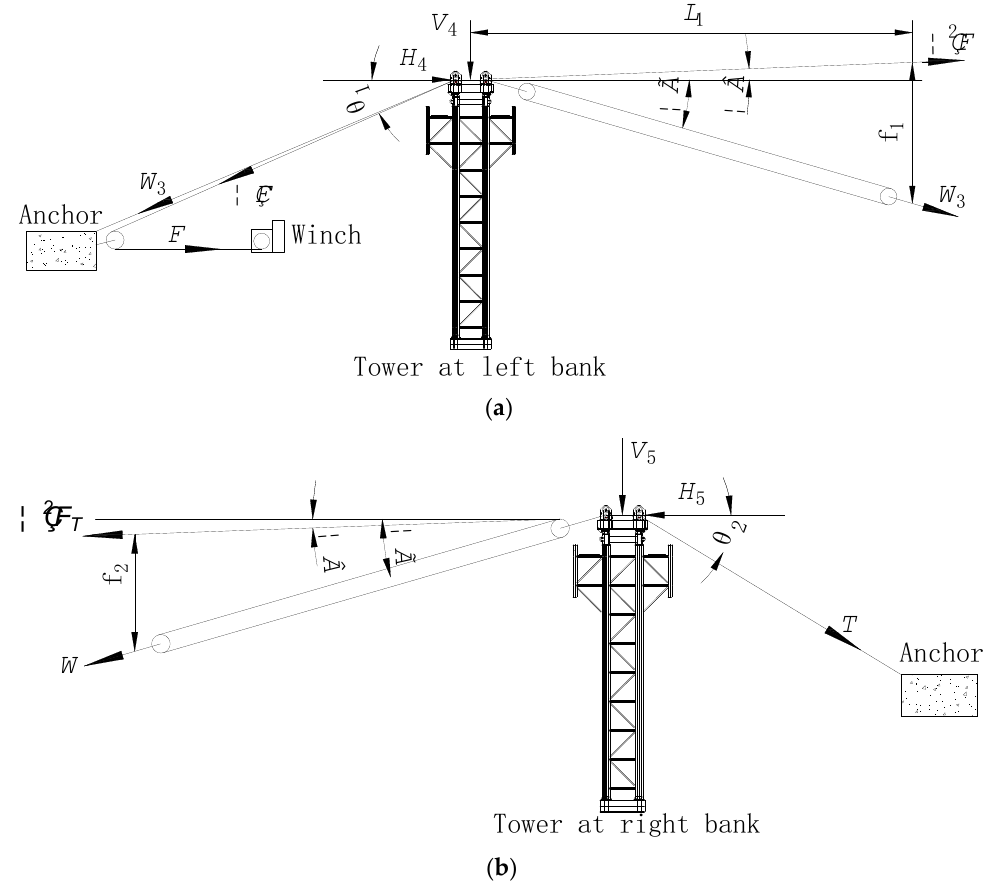
Figure 5. Schematic diagram of calculating the forces acting on a tower from a towing cable: ( a ) left bank; ( b ) right bank.